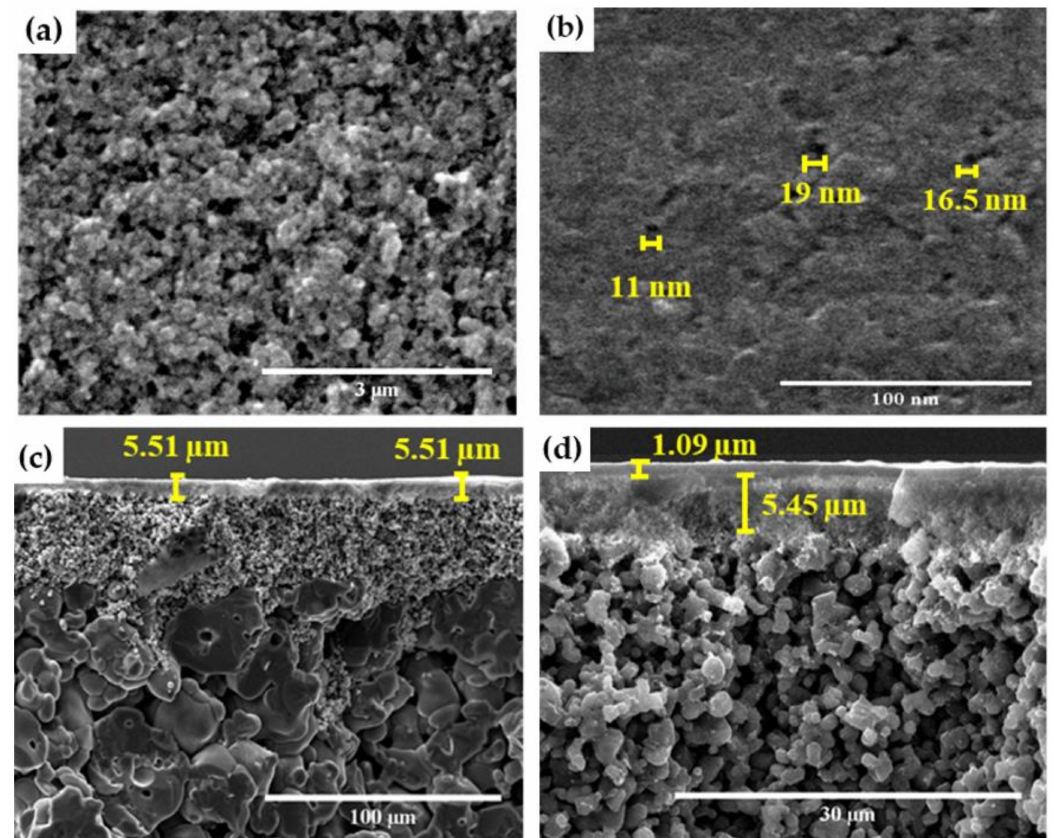
Figure 2. Scanning electron micrographs on the surface of ( a , b ) Ceramic support(CS) and 10% wt. CSCM, and ( c , d ) the cross section of CS and 10% wt.